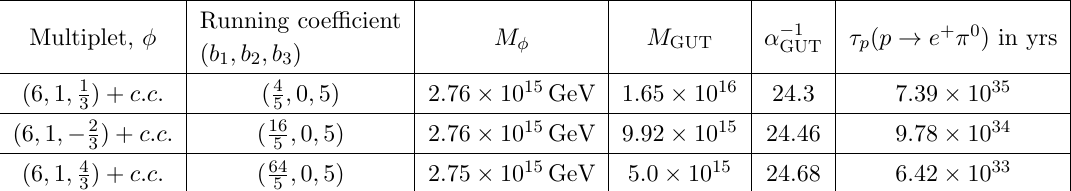
Table 7 . Three example scenarios of gauge coupling uni(cid:12)cation which invoke small threshold correction from a single color-sextet multiplet and its conjugate and the corresponding d = 6 proton decay lifetime. Concerning the quoted values of the proton decay lifetime, we stress the fact that these are just estimates, since we have not included the threshold corrections from the other (cid:12)elds except the color-sextet. Each of these scenarios can be considered viable once all the threshold corrections are taken into